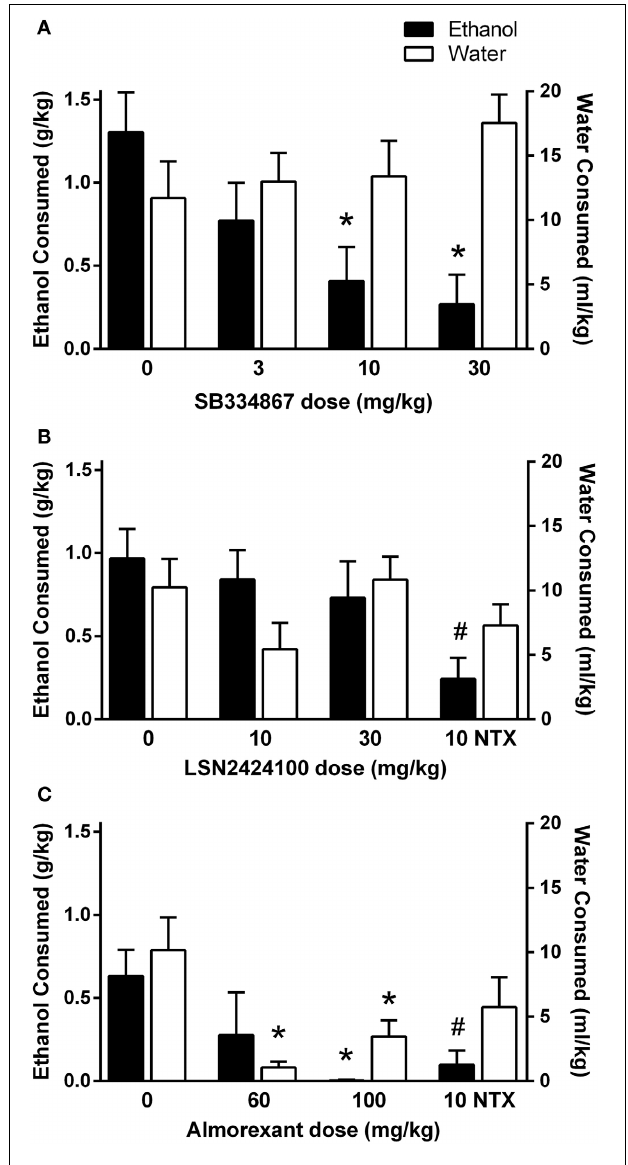
FIGURE 1 | Home cage 2-bottle choice drinking in P rats during the first 3hofthedarkcycle.(A) SB334867( n = 10)reducedethanolintakeatdoses of 10 and 30mg/kg, without altering water consumption. (B) LSN2424100 ( n = 10)didnotsignificantlyinfluenceethanolorwaterintake.Naltrexonewas included as a positive control at a dose (10mg/kg) that selectively reduced ethanolintake(indicatedby#, p < 0 . 05). (C) Almorexant( n = 8/dose)reduced ethanol intake at the 100mg/kg dose while also suppressing water intake at the 60 and 100mg/kg doses. Naltrexone was included as a positive control at a dose (10mg/kg) that selectively reduced ethanol intake (indicated by #, p < 0 . 05). Filled bars indicate ethanol consumption (g/kg) on the left y-axis; open bars indicate water consumption (ml/kg) on the right y-axis. ∗ indicates significant difference ( p < 0 . 05) relative to vehicle-treated controls.